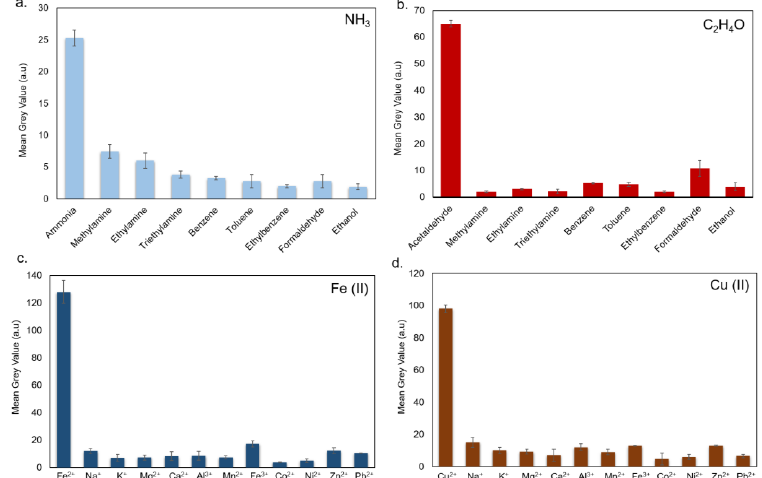
Figure 11. Interferences assay for NH 3 and C 2 H 4 O ( a , b ) and Fe(II) and Cu (II) ( c , d ). The values were expressed as MGV. Data reported were the average of three independent experiments ± SD.